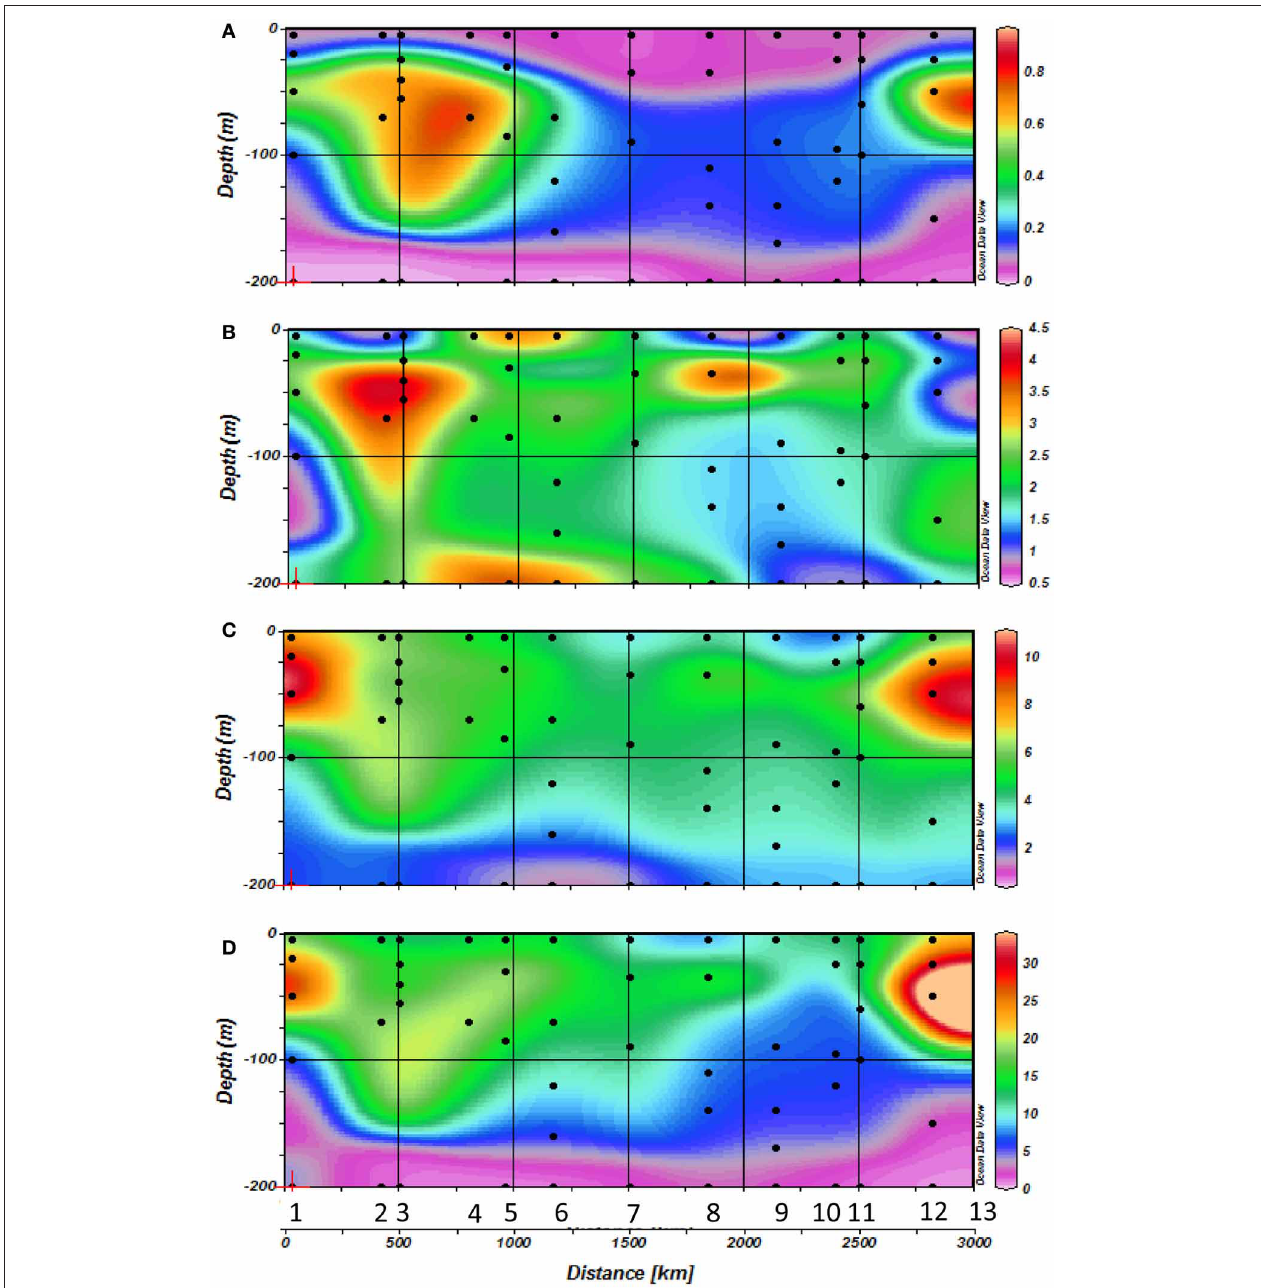
production ( < php) rates along the transect with station numbers (1–13) and sampling depths indicated by dots during